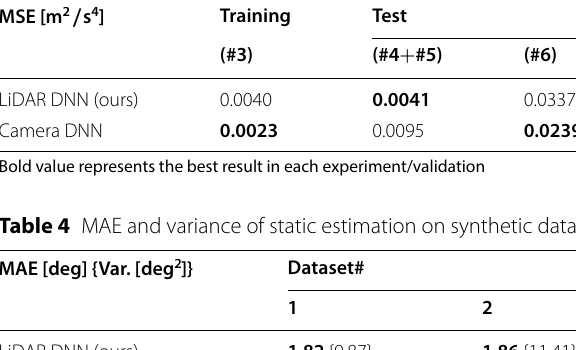
Table 3 Loss after 200 epochs of fine-tuning MSE [ m 2 ∕ s 4 ]